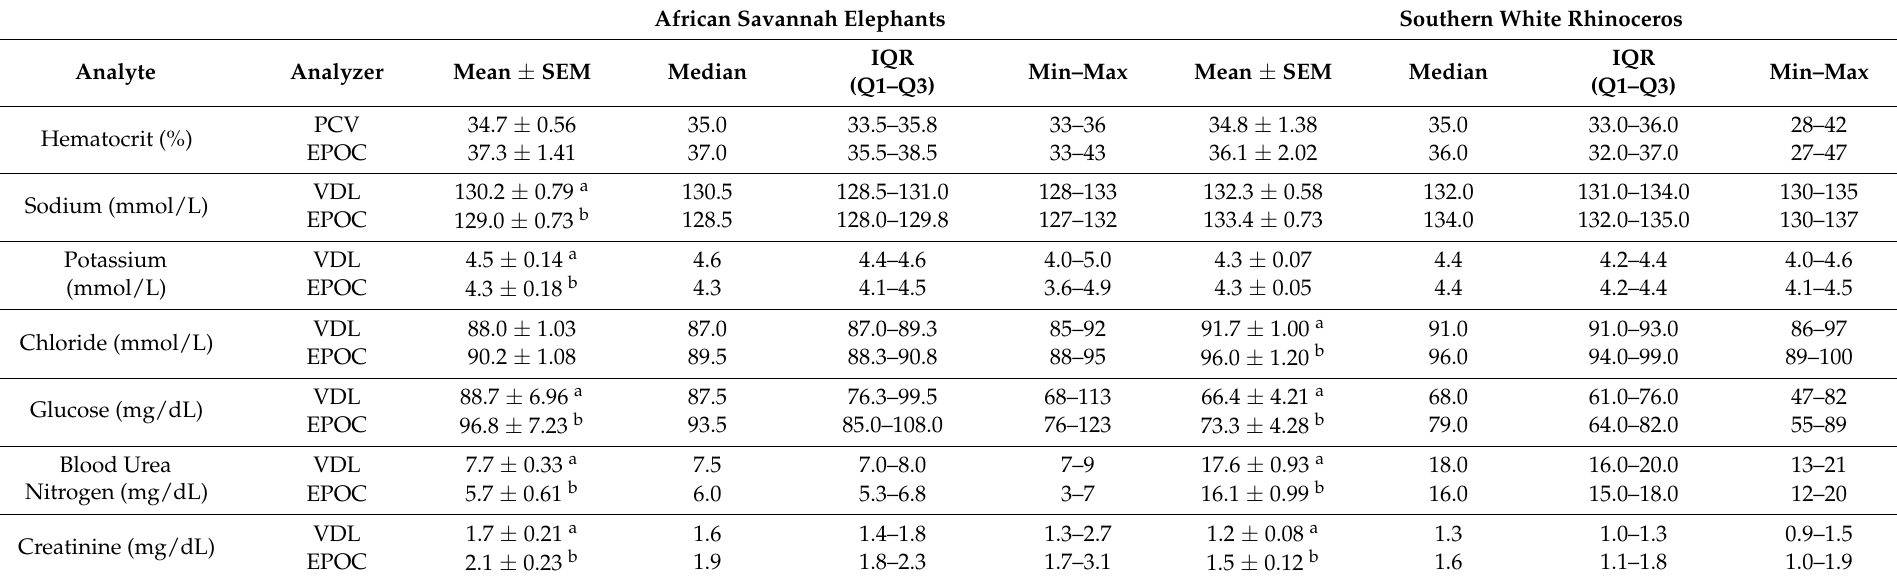
Table 1. Descriptive statistics of hematocrit and biochemical values in African savanna elephants ( Loxodonta africana ; n = 6) and southern white rhinoceros ( Ceratotherium simum simum ; n = 9) measured by the EPOC analyzer, manual measurement of packed cell volume (PCV), and a veterinary diagnostic laboratory